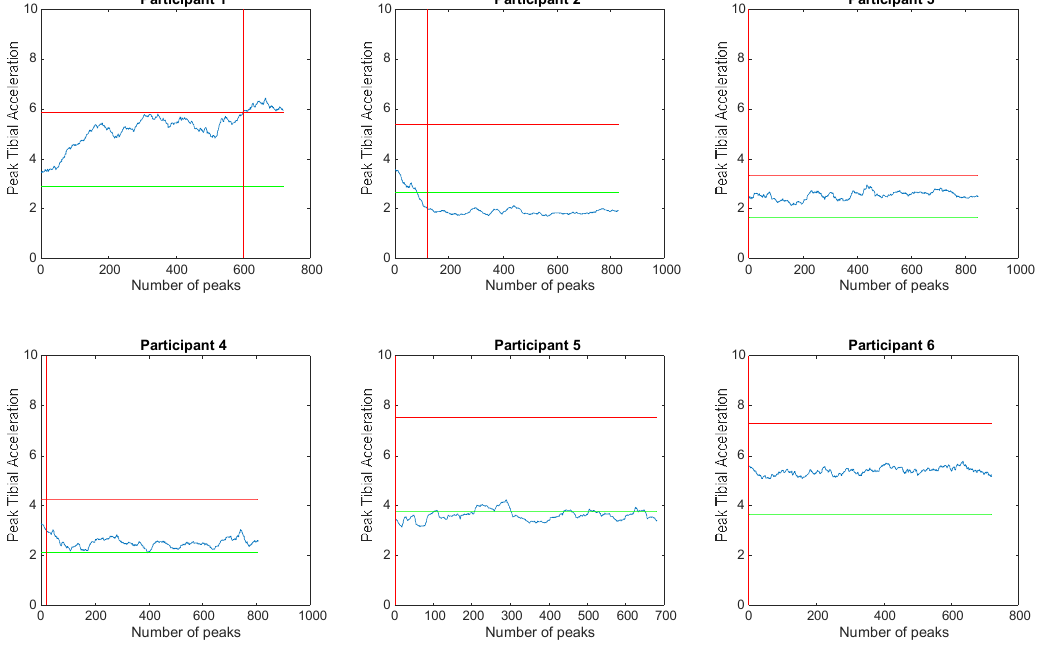
Figure 2. Moving average of peak tibial acceleration during the feedback condition (blue spiked line), separate subplots for every participant. The red (upper horizontal) line represents the mean peak tibial acceleration of the baseline condition and the green (lower horizontal) line represents the target that was set for that participant. The red vertical line represents the start of the